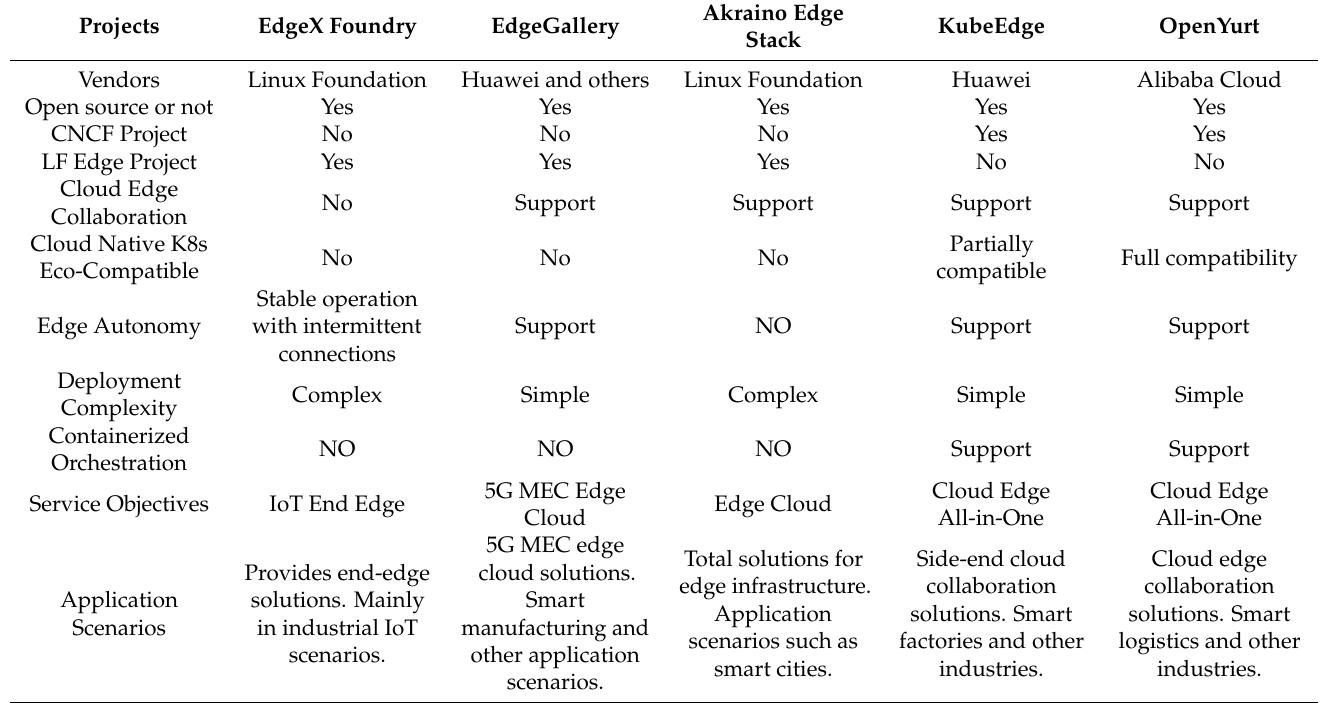
Table 2. Comparative study of edge computing platforms.